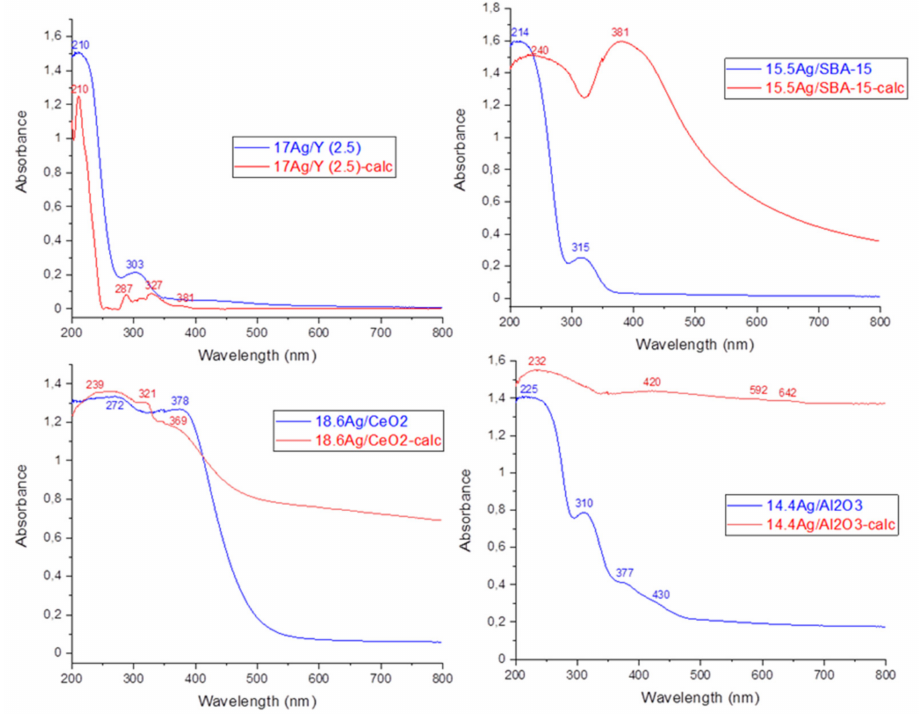
Figure 2. DRS-UV-Vis spectra of silver impregnated supports: only vacuum-dried at 80 ◦ C (blue); calcined at 500 ◦ C (1 h)